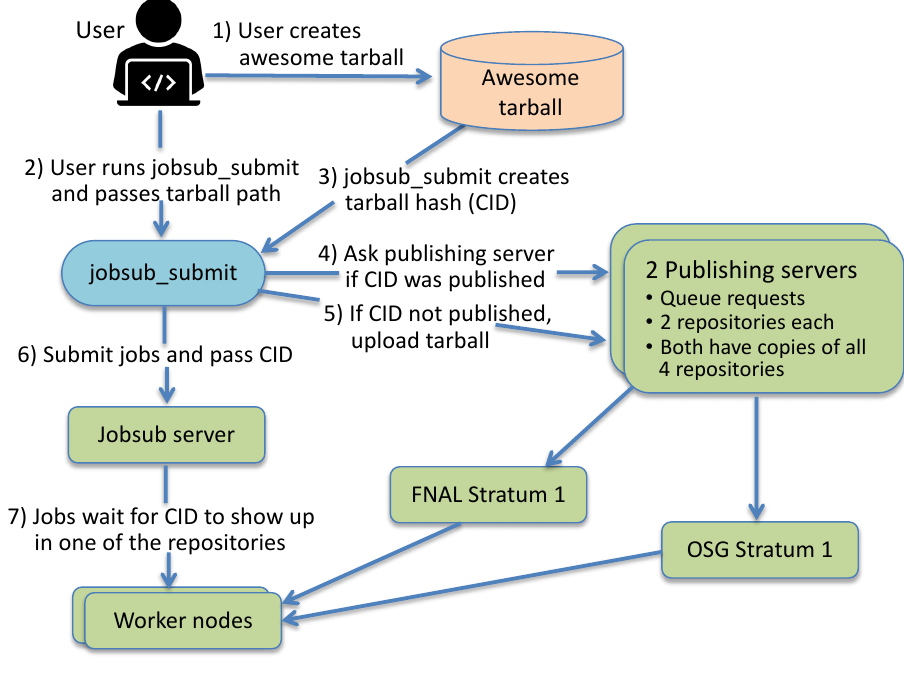
Figure 1. Control flow of user tarball publication to